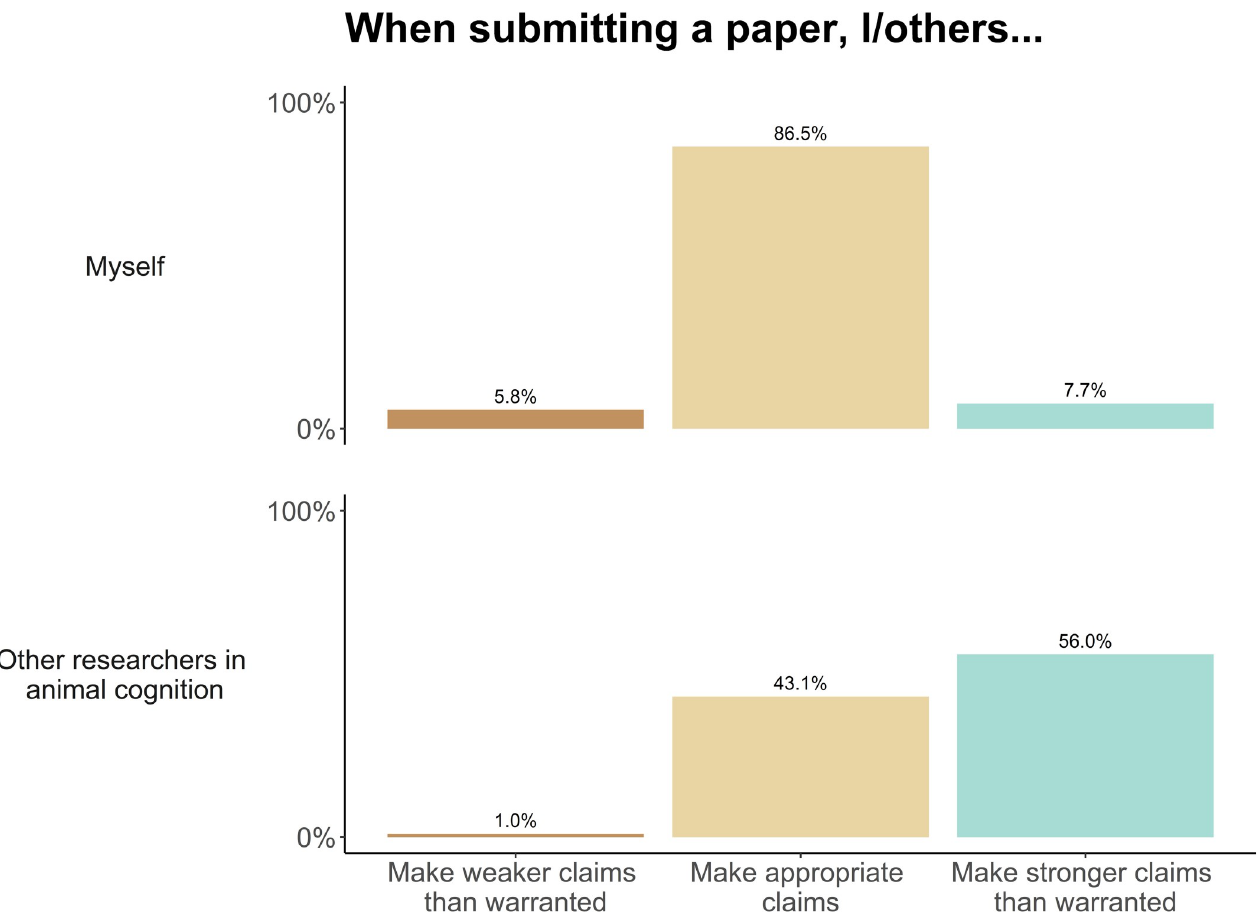
Fig 9. Animal cognition researchers’ beliefs about overclaiming and underclaiming when submitting research articles for publication, N = 210.